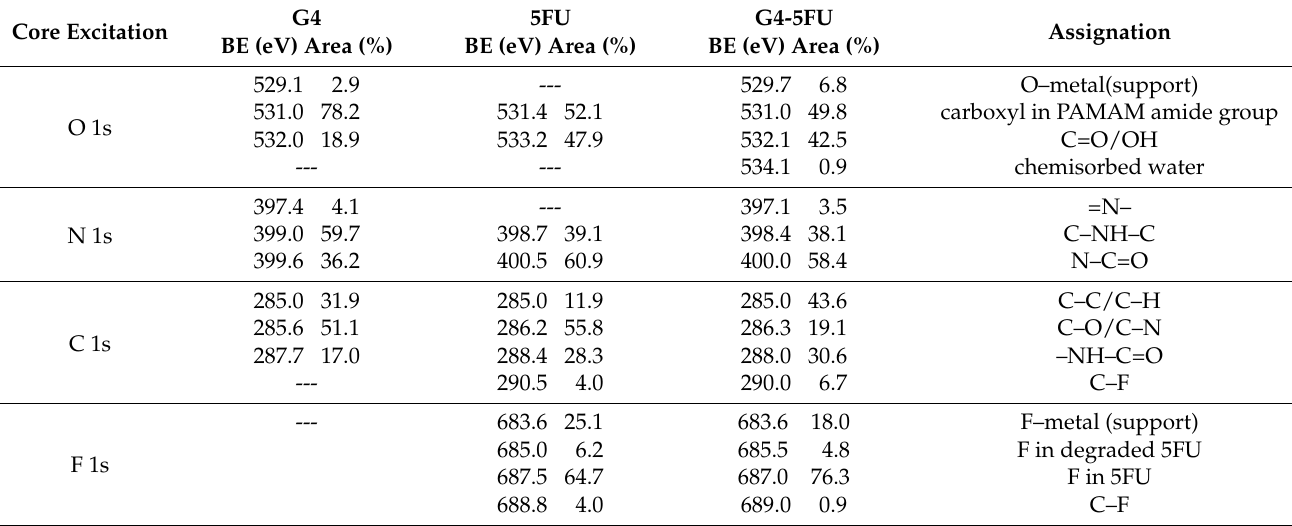
Table 3. XPS data of G4PAMAM, 5FU, and G4-5FU